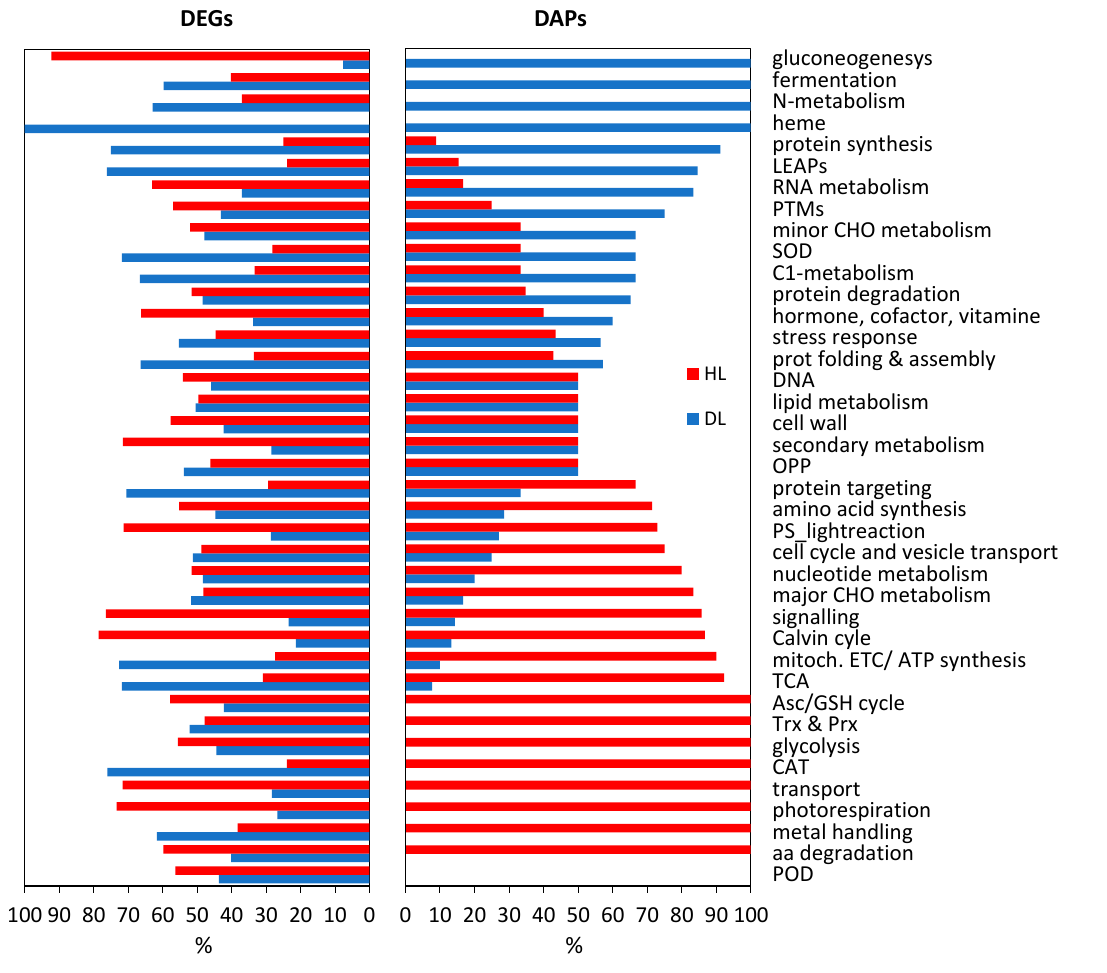
Figure 3. Functional classes of DEG and DAPs in R. serbica HL and DL. A detailed classification of DEGs and DAPs is given in Supplementary Tables S4 and S5.